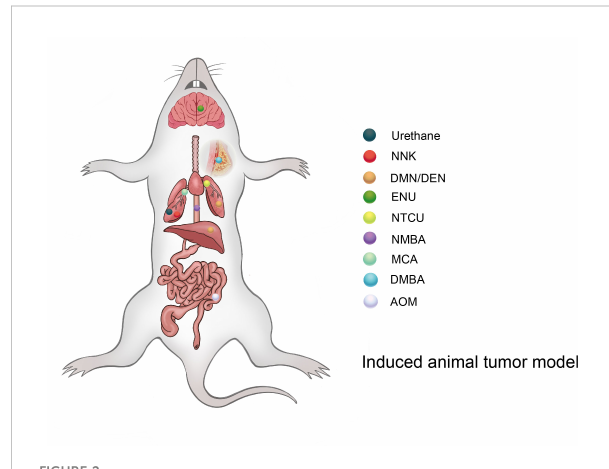
FIGURE 2 Different types of compounds can induce tumors in different organs of mice